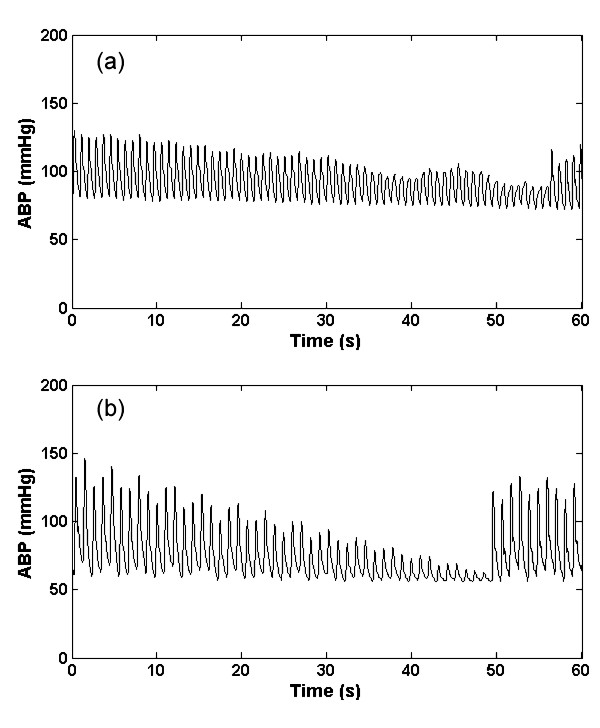
Artifact 3, (app); Real (a) and Simulated (b) ABP reduced pulse pressure in window using a 5–10 Hz FIR filter plus Kaiser window.